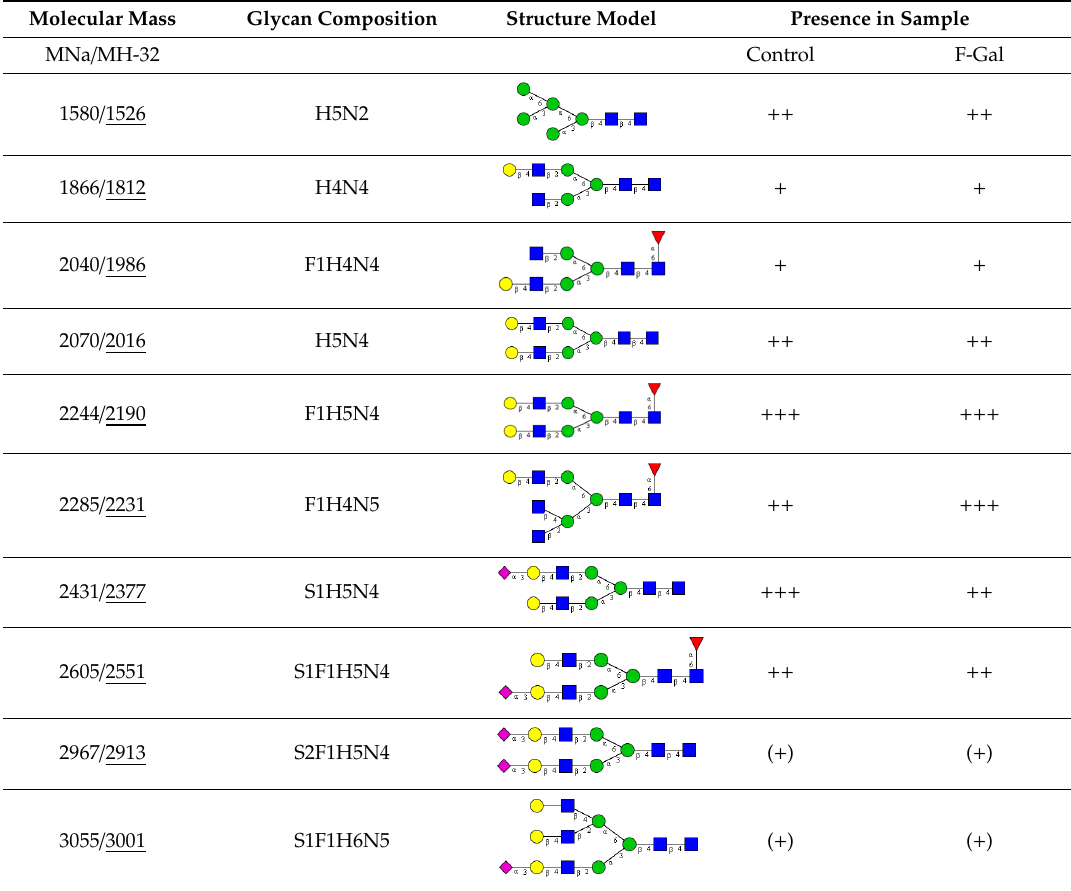
Table 1. Mass spectrometric N-Glycoprofiling of chicken netrin-1 expressed in HEK293 cells in the absence or presence of F-Gal.